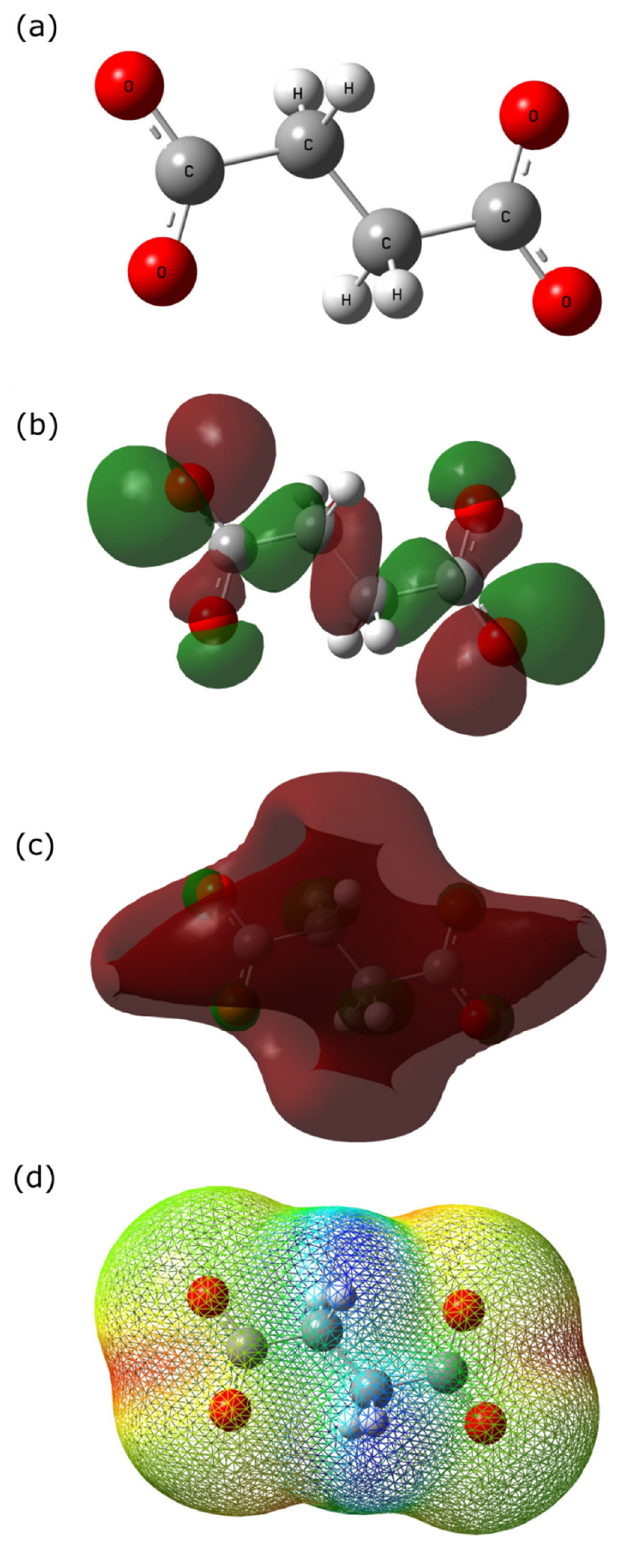
Figure 15. Quantum chemical calculations: ( a ) Optimized molecular structure of succinate anion. Frontier molecular orbital density distribution of succinate anion using DFT: ( b ) HOMO, ( c ) LUMO, and ( d ) electrostatic potential mapping. In ( b , c ), green indicates a positive orbital wave function, while red represents a negative orbital wave function. In ( d ) red indicates high electrostatic potentials while blue indicates a low electrostatic potential.